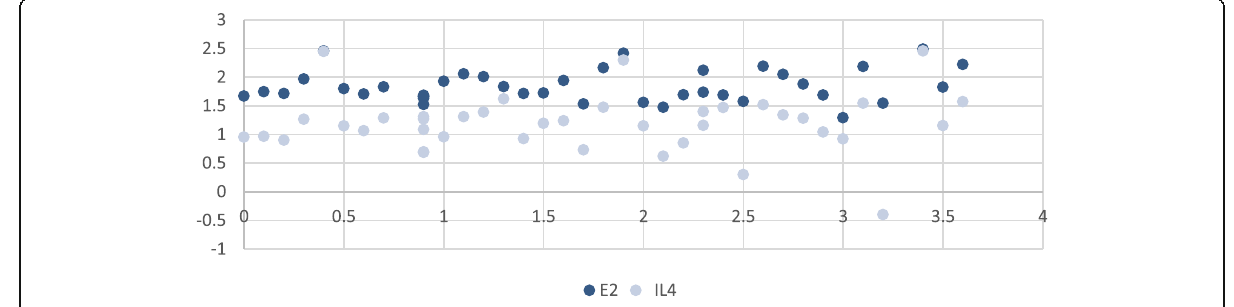
Fig. 2 Correlation between estrogen levels and interleukin 4 (IL-4) levels in patients